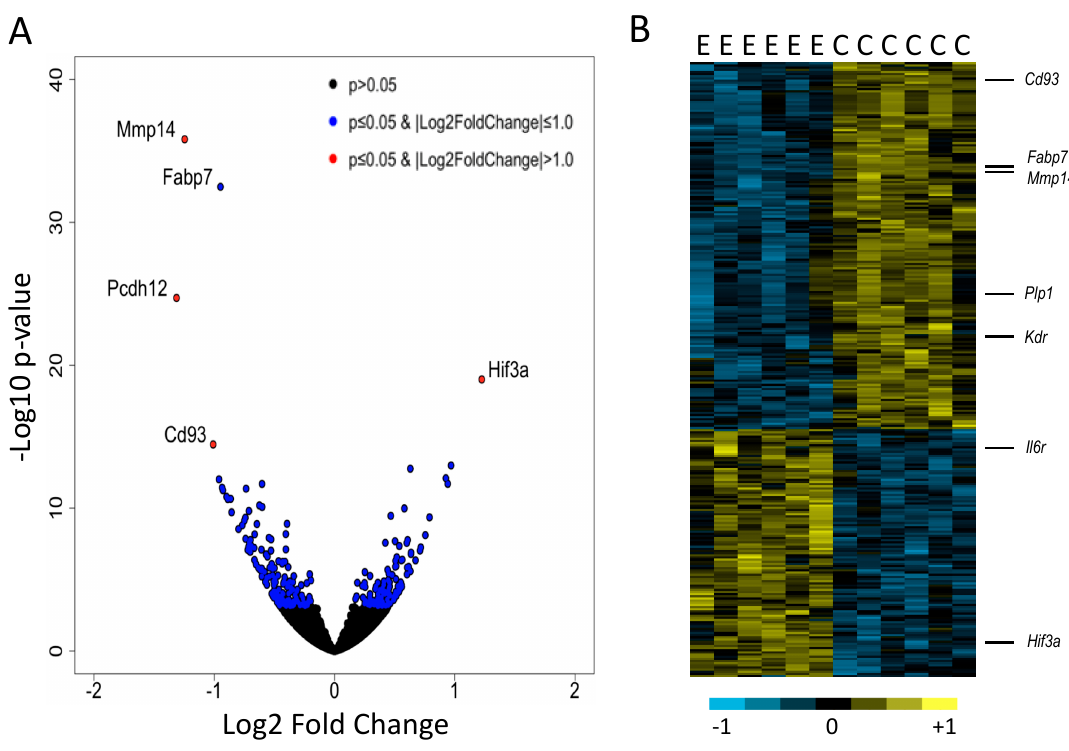
Figure 1. ( A ) Volcano plot showing differentially expressed genes (DEGs) (in color). Highlighted are the top statistically significant DEGs, up-regulated in the CIE group (on the right) and down-regulated in the CIE group (on the left). ( B ) Heat map of DEGs at 5% false discovery rate. Ethanol CIE group (E) and control air group (C). Representative cell and tissue type-specific genes are shown on the right.